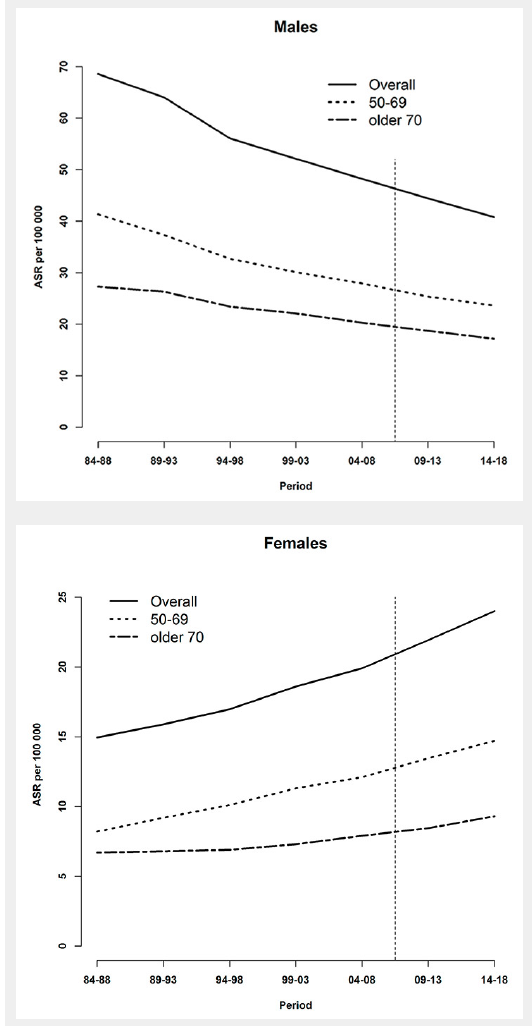
Age-specific and overall age-standardised tobacco-related cancer mortality rates (per 100,000), observed (during 1984–2008) and predicted (posterior median during 2009–2013 and 2014–2018) at the national level for (a) males and (b) females. The vertical line indicates the start of the prediction